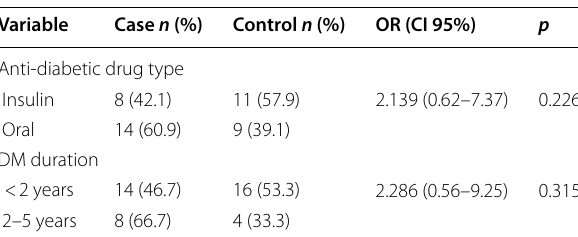
Table 3 Bivariate analysis of other variables and painful diabetic